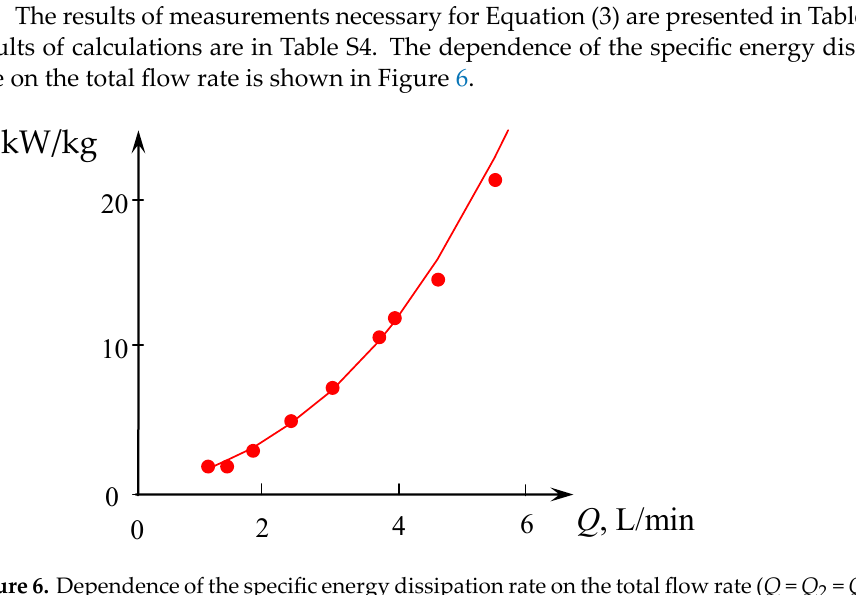
Figure 5. Dependence of the specific energy dissipation rate on the total flow rate ( Q = Q 2 = Q 1 a + Q 1 b ) for solutions supplied through the upper tangential and axial nozzles (TU1, Ax). Points—experimental data, line—dependence ε = 0.1644 Q 2.973 ( Q is in L/min, ε is in kW/kg). 3.1.2. Liquids Supplied to the MRISF‑2 through Two Upper Tangential Branch Pipes (TU1, TU2)